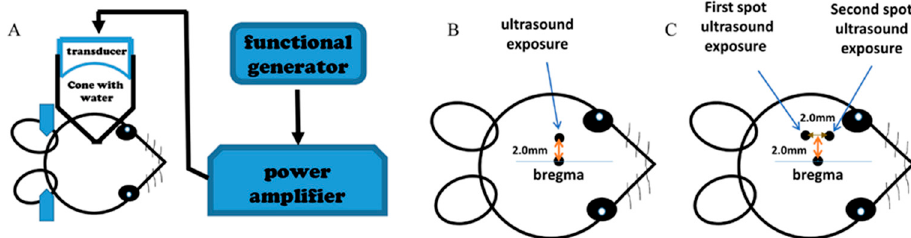
Figure 1. Ultrasound equipment setup and sonication locations. ( A ) Ultrasound equipment